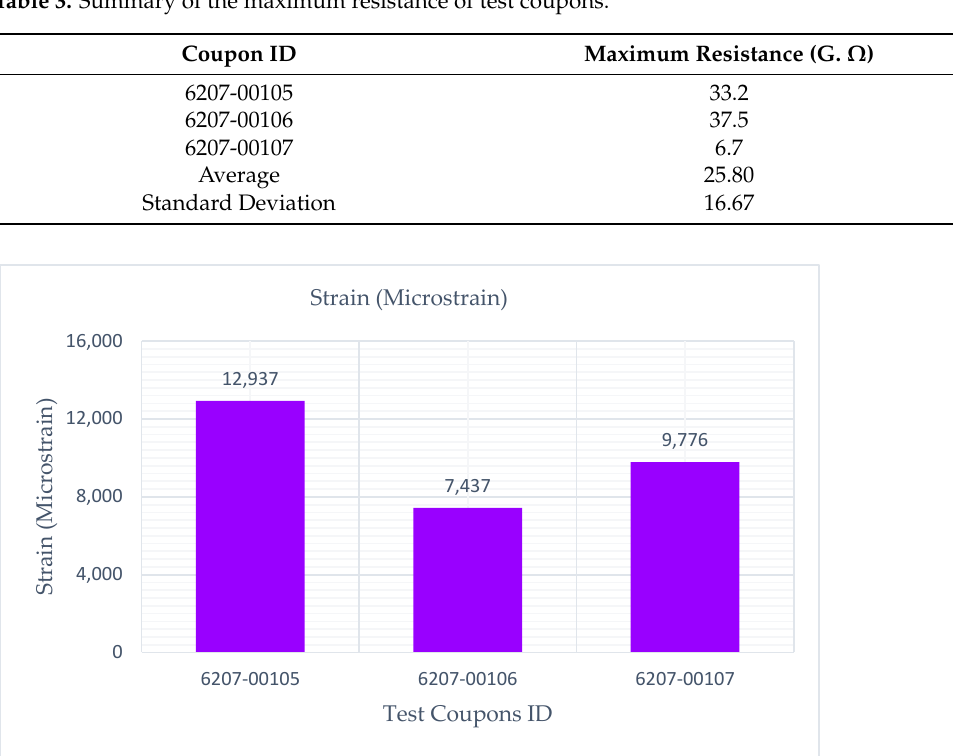
Figure 11. Strain comparison of test coupons corresponding to associated maximum resistance values.